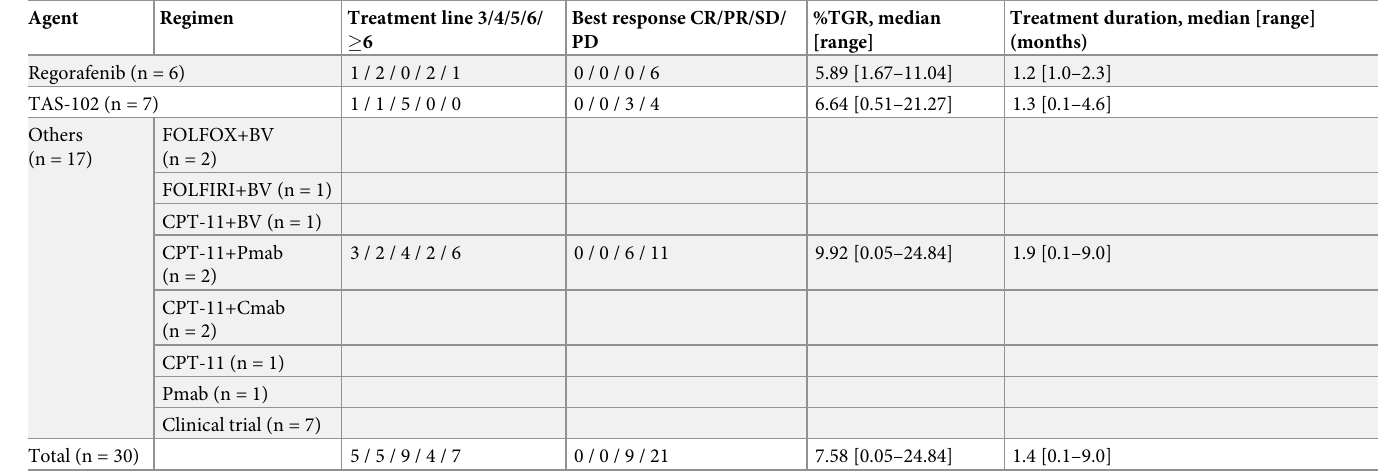
Table 3. Prior-Cx regimens (30 cases).